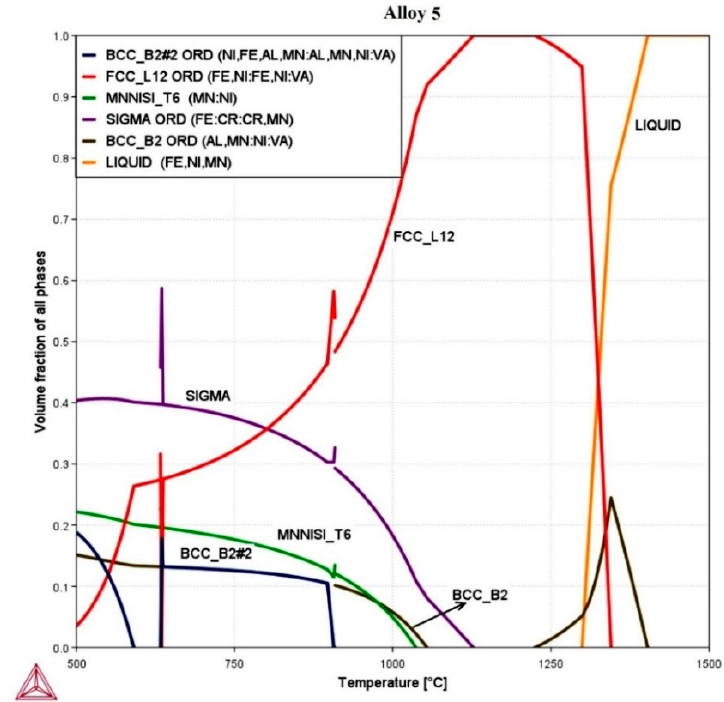
Figure 6. Phase diagram of Alloy 5 (Fe 35 Mn 20 Ni 22 Cr 15 Al 5 Si 3) HEAs. Alloy 6 (Fe 36 Mn 20 Ni 20 Cr 16 Al 5 Si 3 ) represents the last trial of this study, as shown in Fig- ure 7. The aim with Alloy 6 was to increase the strength by increasing the BCC phase fraction by a slight increase in the Cr content to be 16 at.% and reducing Ni back to 20 at.%, while maintaining less silicide formation by keeping Si content as its lower content of 3%. In Alloy 6, the FCC phase became the main constituent, and a slightly higher amount of B2 phase was observed compared to Alloy 5, and no silicides present at high temperature. Alloy 6 was also deformable and the results will be presented elsewhere. The phase identification of the 6 alloys in the study was carried out by XRD. Figure 2 shows a high degree of consensus with the phase constitution of the alloys predicted by Thermo-Calc in Figures 1 and 3–7, as explained below.